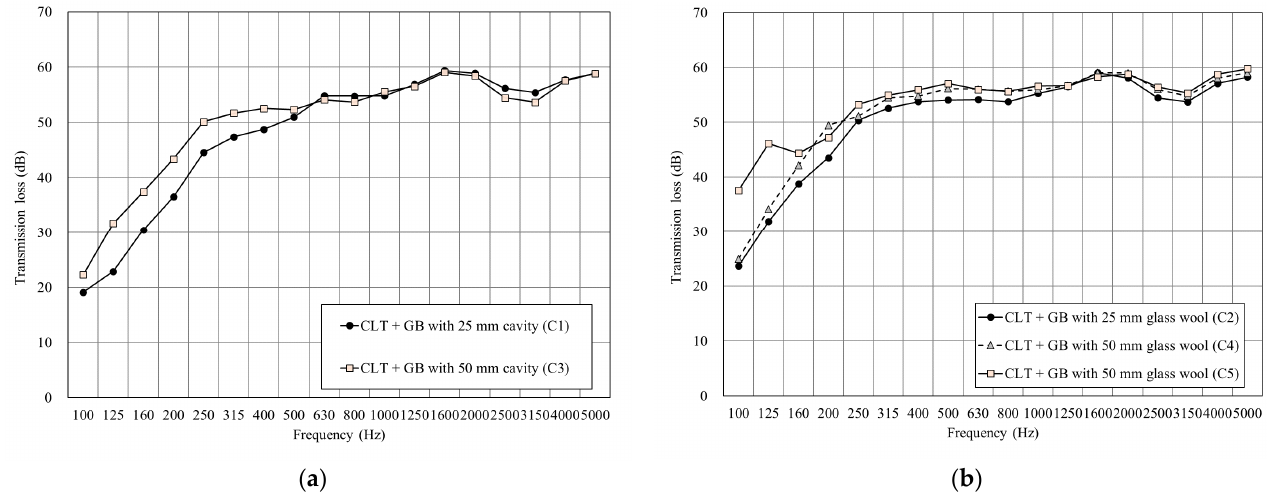
Figure 8. The sound insulation performance of CLT + GB. ( a ) Comparison of the test specimens with different cavity thicknesses. ( b ) Comparison of the test specimens with different glass wool thicknesses.